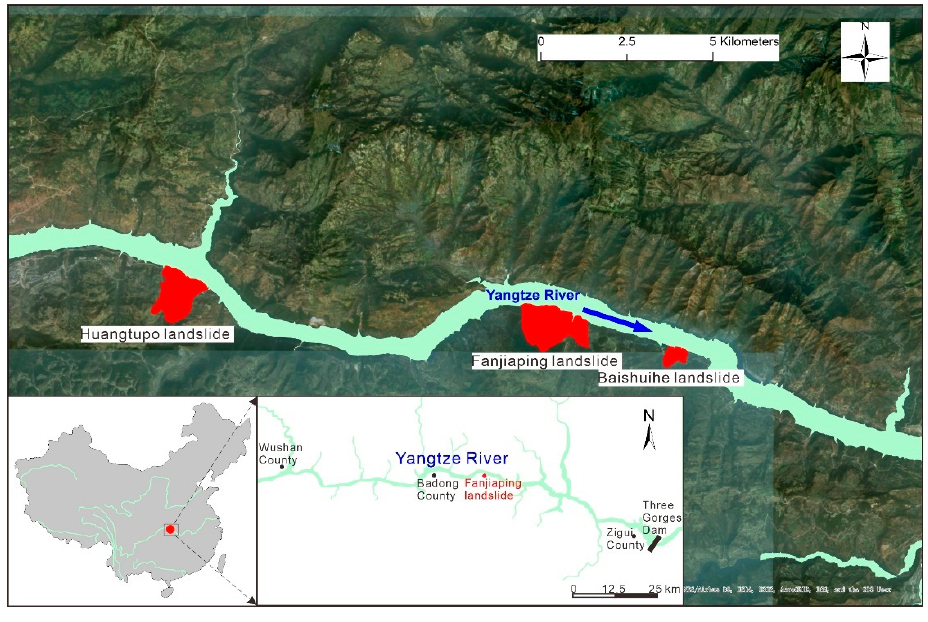
Figure 3. Location of the landslide site.